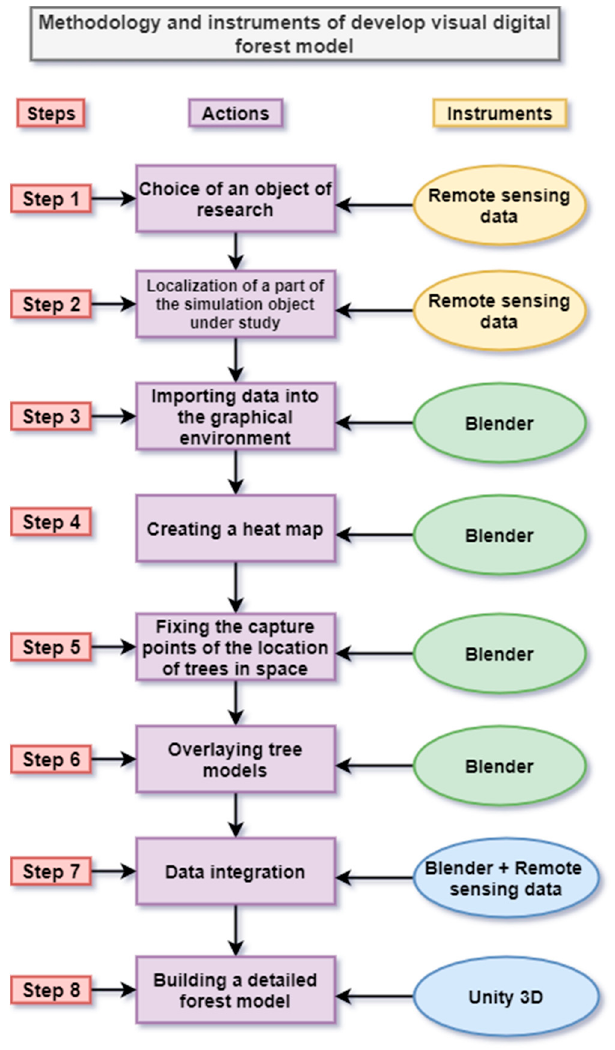
Figure 10. Methodology for developing a visual digital forest model.